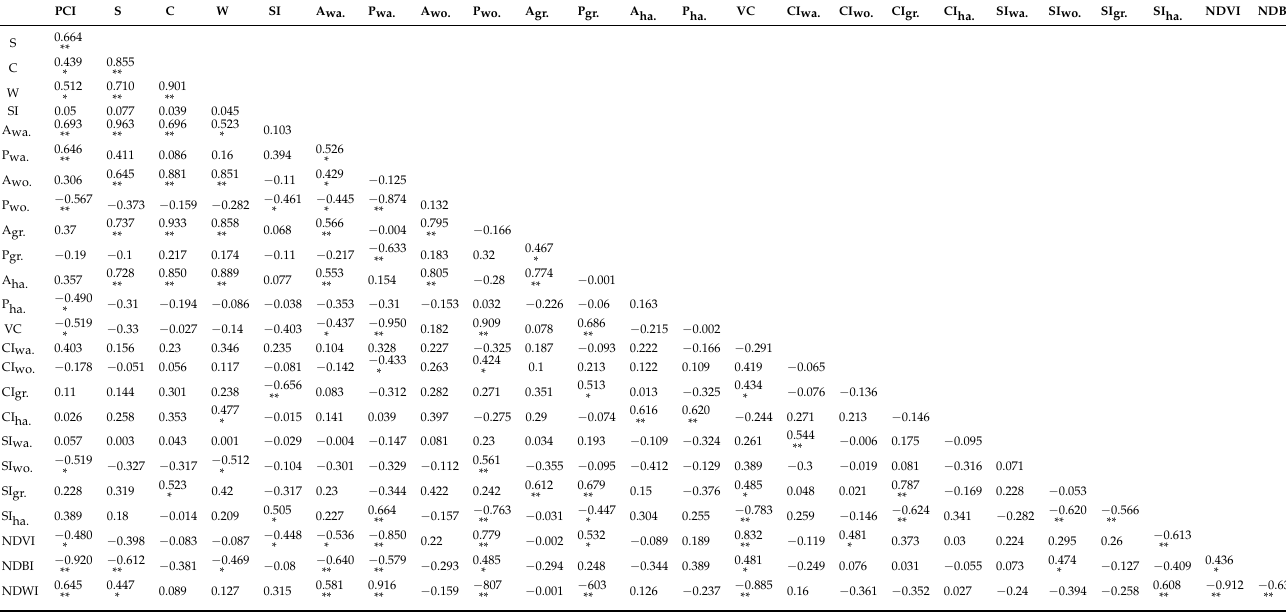
Table A1. Pearson correlationsamongthe PCIvalues and all variables indicating park structure characteristics. PCI CIwa. CIwo. CIgr. CIha. SIwa. SIwo.